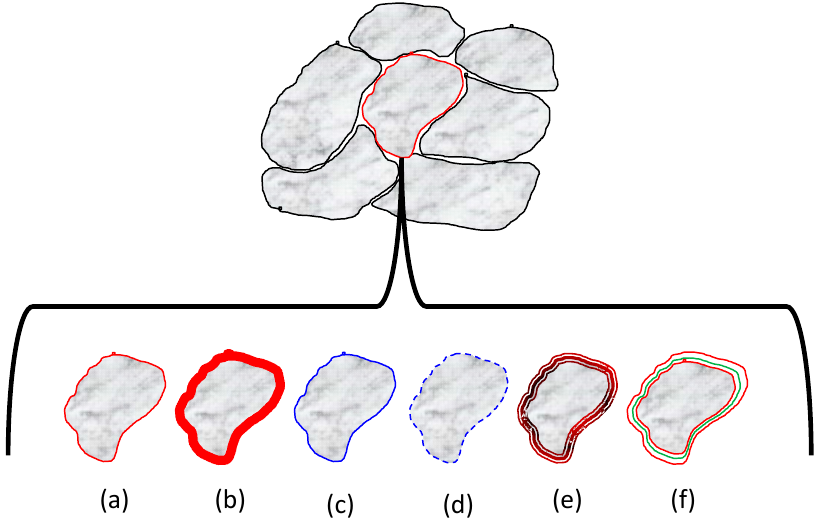
Figure 2. Types of SMC insulating coatings: ( a ) organic layer, ( b ) thick organic layer, ( c ) inorganic layer, ( d ) phosphatized inorganic layer or similar techniques, ( e ) organic layer filled with nanoparticles, and ( f ) multilayers with the possible hybrid nature of coatings.